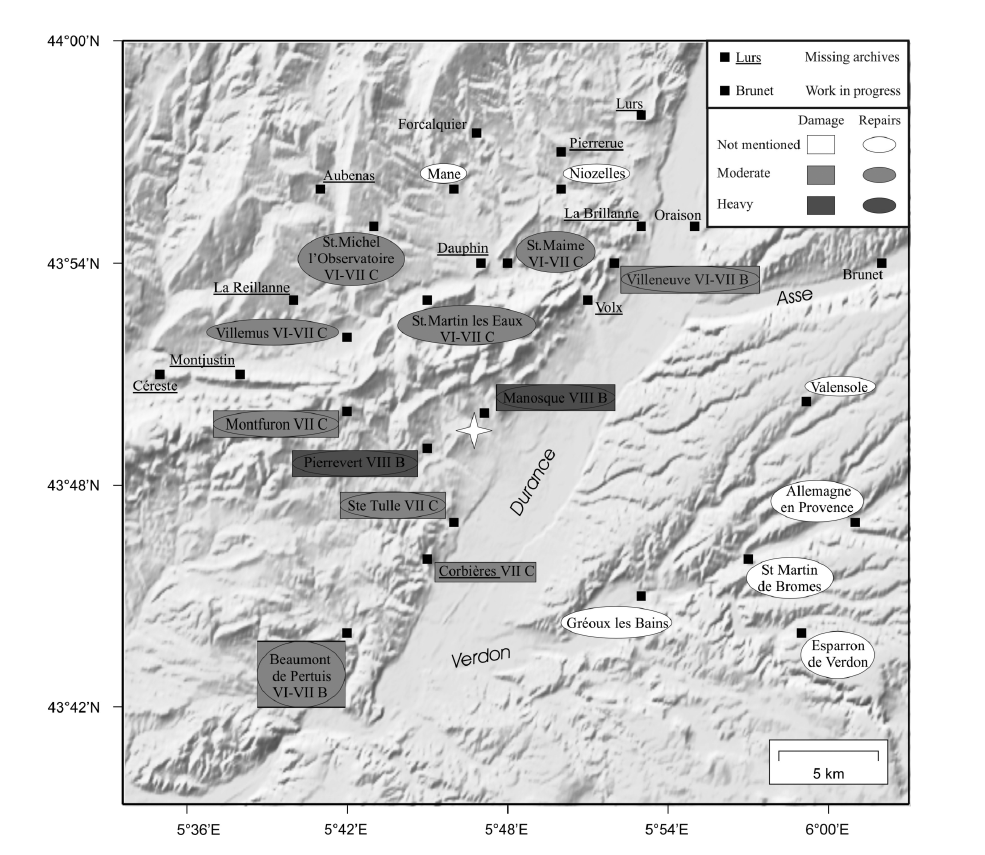
Fig. 3. Map showing the effects of the 14 August 1708 Manosque earthquake in the epicentral area estimated (table II) from both damage (squares) and repairs (ellipses). Based on this new data set, the damage area is further increased to the north ( cf. fig. 1) by the addition of data in Montfuron, Villemus, St. Martin les Eaux, St. Michel l’Observatoire, St. Maime and Villeneuve. The epicenter (star) is taken from SISFRANCE